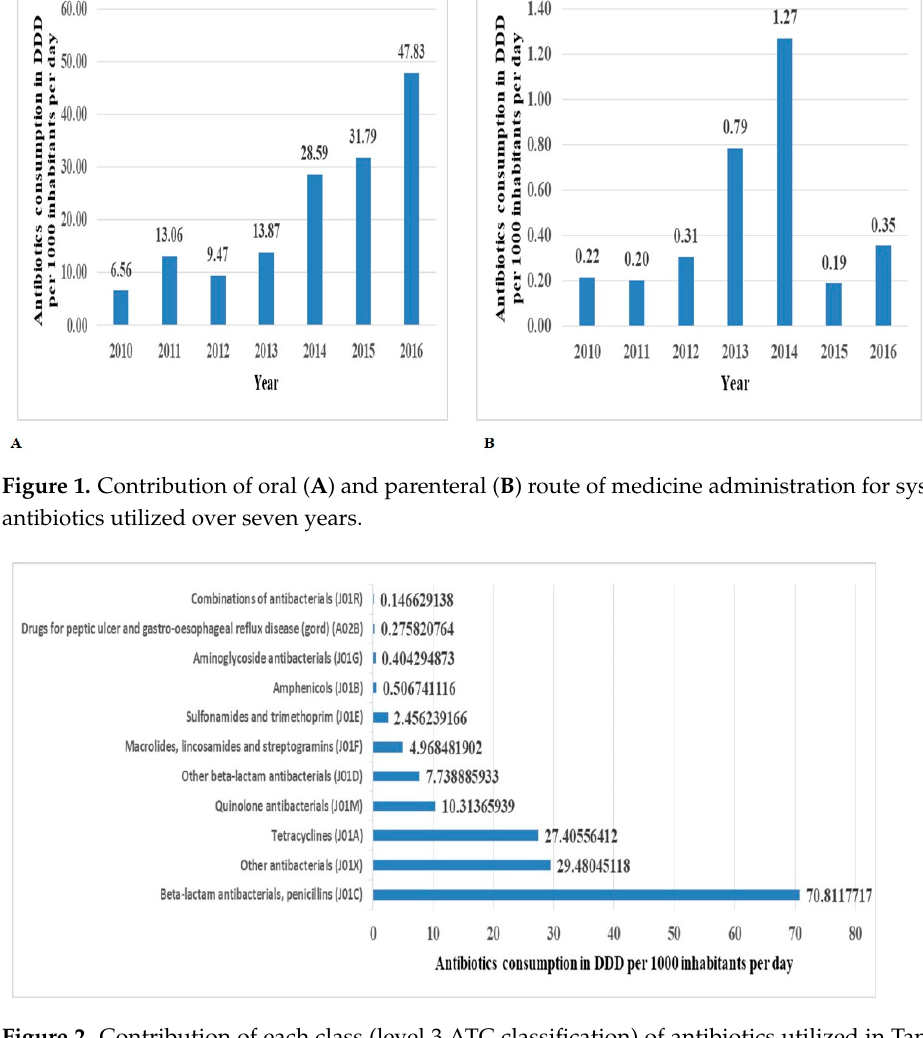
Figure 2. Contribution of each class (level 3 ATC classification) of antibiotics utilized in Tanzania from 2010 to 2016.